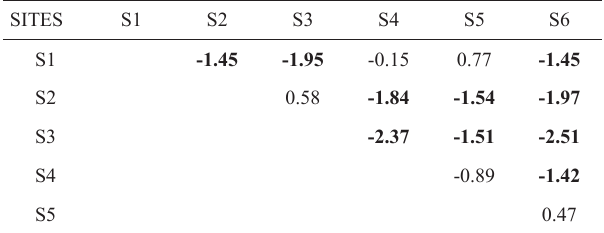
Tab. 3. Results of the Partial Canonical